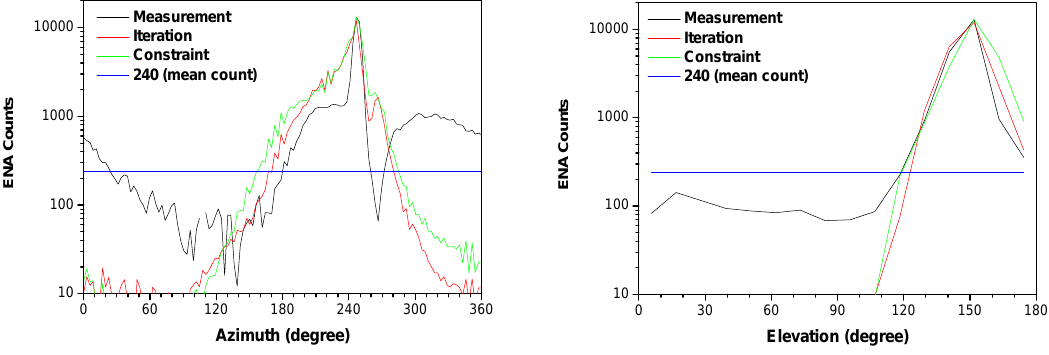
Fig. 12. Comparison of ENA-count distributions versus azimuth (left) and elevation (right) where: the black curves represent the measure- ments shown in Fig. 1 at the ENA intensity maximum; blue lines represent the mean ENA count in Fig. 1; red and green curves represent recovered images from inverted ion fluxes derived, respectively, by iteration (Fig. 11) and by linear constraint (Fig. 8). For further details see the